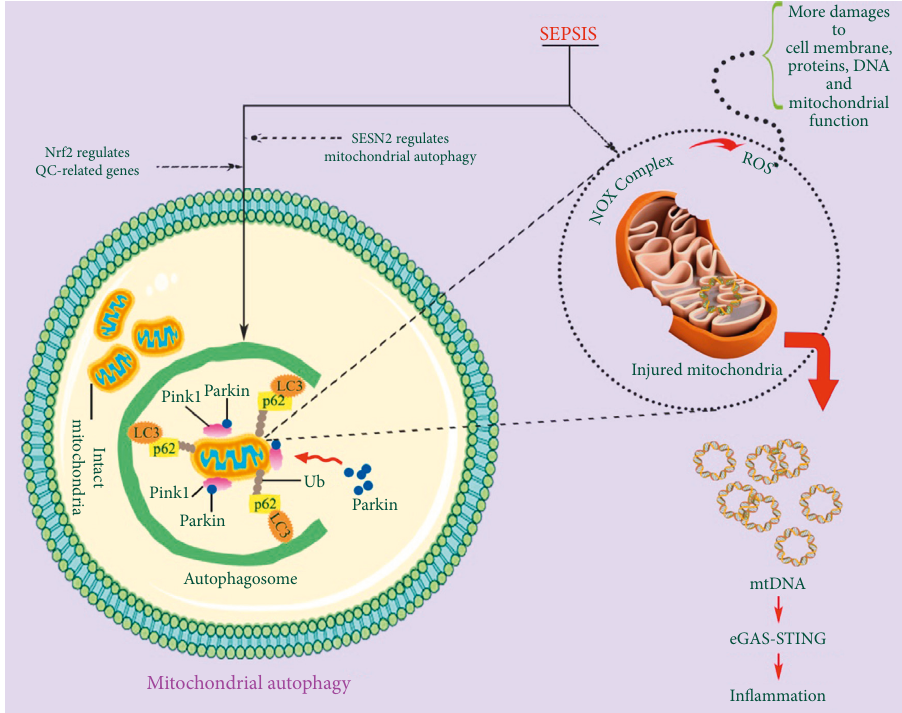
Figure 2: Oxidative stress and mitophagy in damaged mitochondria. The number of damaged mitochondria increases in the initial stage of sepsis. Damaged mitochondria lead to mitochondrial dysfunction via ROS signaling pathways and mtDNA. Autophagy removes damaged mitochondria. Cytokines such as SESN2 and Nrf2 regulate autophagy process. cGAS: cyclic GMP-AMP synthase; LC3: microtubule- associated protein 1 light chain 3; mtDNA: mitochondrial DNA; NOX: NADPH oxidase; Nrf2: nuclear factor erythroid 2-related factor 2; Pink1: PTEN-induced putative protein kinase 1; QC: quality control; ROS: reactive oxygen species; SESN2: sestrin 2; STING: interferon gene stimulator; Ub: ubiquitin